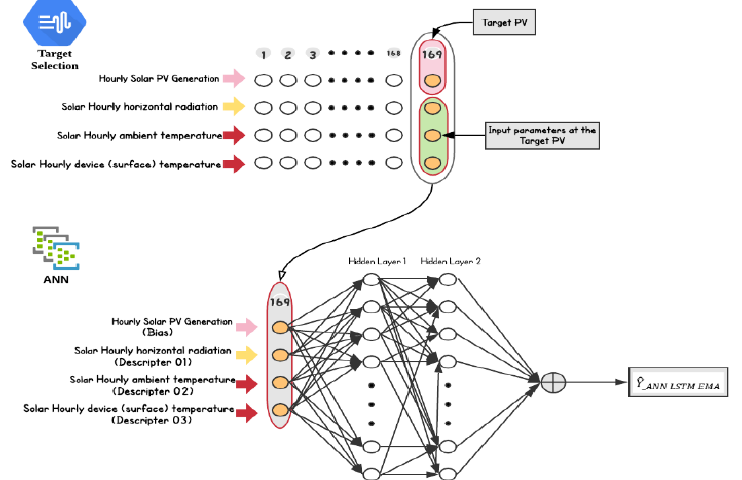
Figure 5. Process of artificial neural network (ANN) estimation, with target selection for the proposed framework.